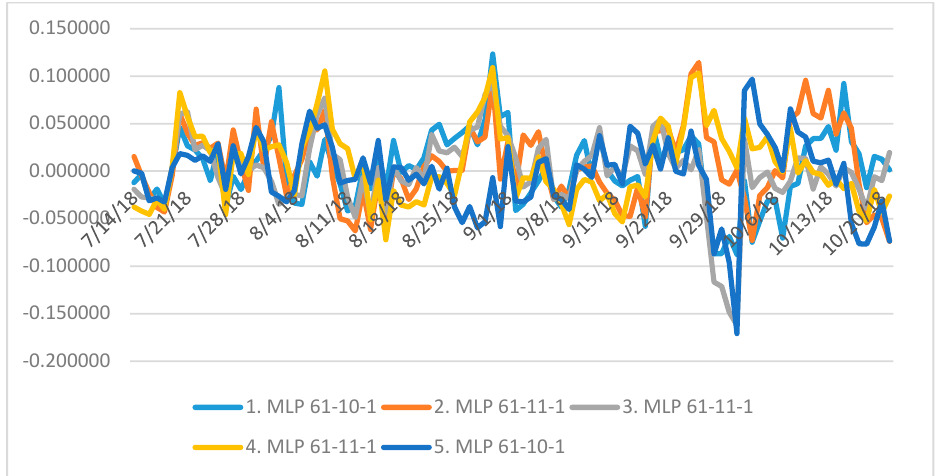
Figure 9. Development of residuals of equalized time series between 14th July and 21st October 2018. (Source: Own processing.)